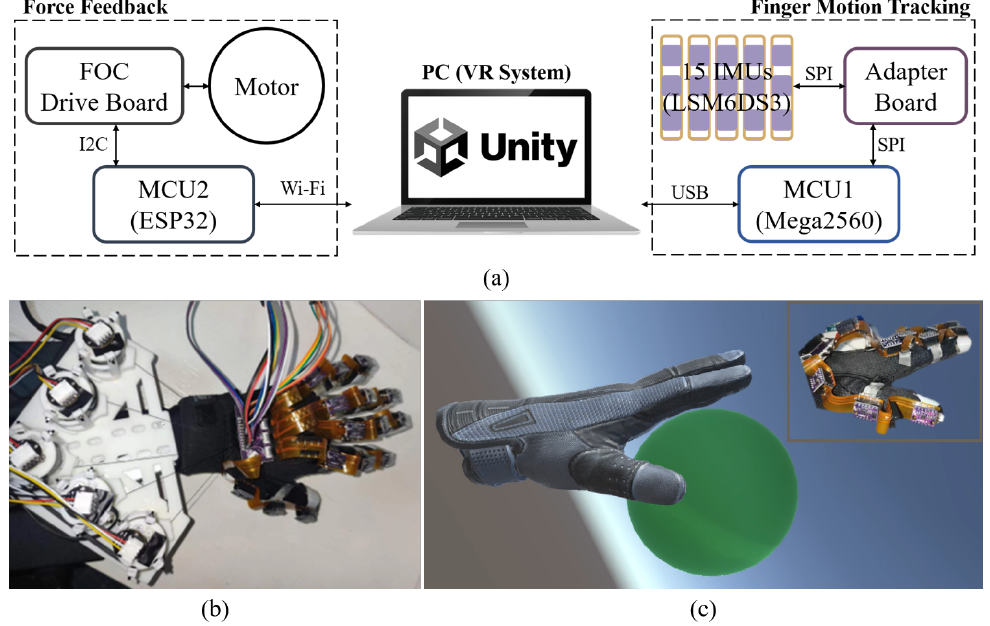
Figure 1. ( a ) Architecture of the proposed soft robotic glove system for rehabilitation. ( b ) Prototype of the integrated soft robotic glove. ( c ) Demonstration of grasping a virtual ball in a home-built VR